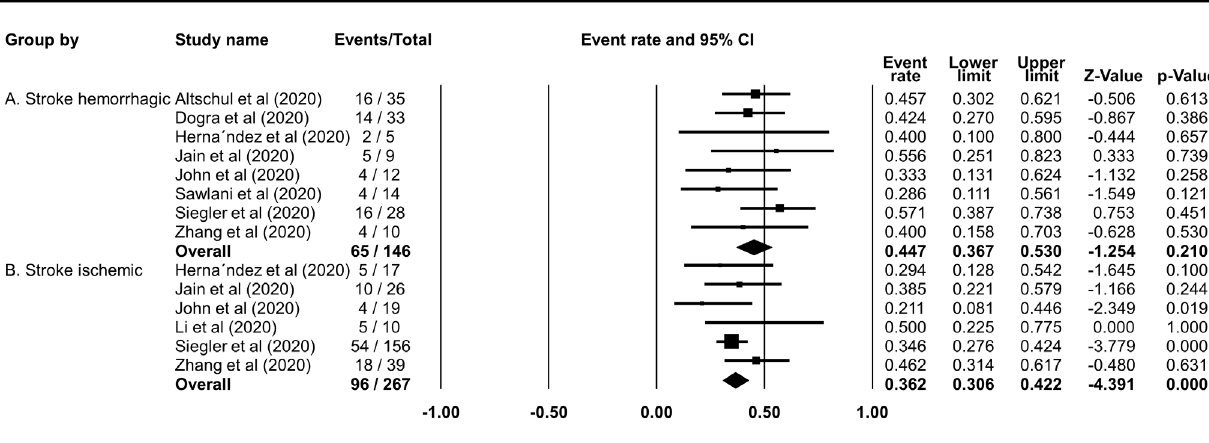
Figure 4. Forest plot of the mortality rate of haemorrhagic and ischemic stroke in COVID-19 patients. ( A ) The pooled mortality rate of haemorrhagic stroke is 44.72% (95% CI 36.73%–52.98%, p=0.2099); heterogeneity p=0.7343, I 2 =0%, and Egger’s p=<0.0001. ( B ) The pooled mortality rate of ischemic stroke is 36.23% (95% CI 30.63%–42.24%, p<0.0001); heterogeneity p=0.438, I 2 0%, and Egger’s